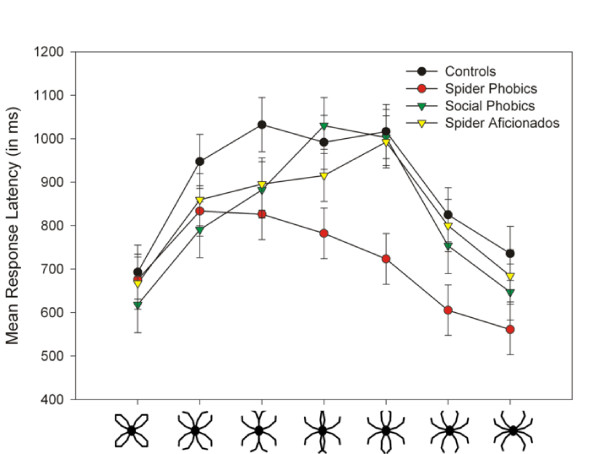
Stimulus dependent reaction times. Stimulus dependent RTs: Mean response latency (in ms) and standard errors for the classification of each picture depicted separately for each group.